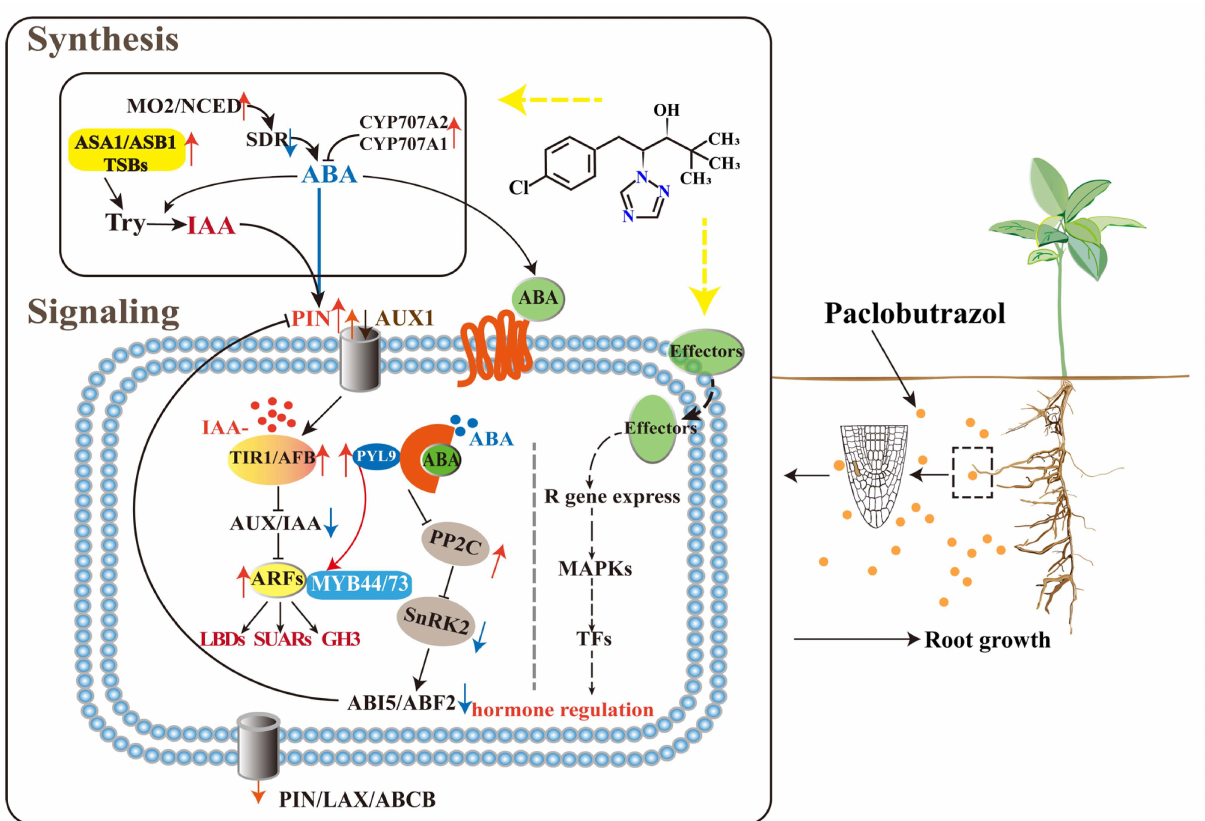
Figure 6. Possible molecular mechanisms of P. bournei roots in response to paclobutrazol based on hormonal regulation. Red and blue indicate up- and down-regulated phytohormones,